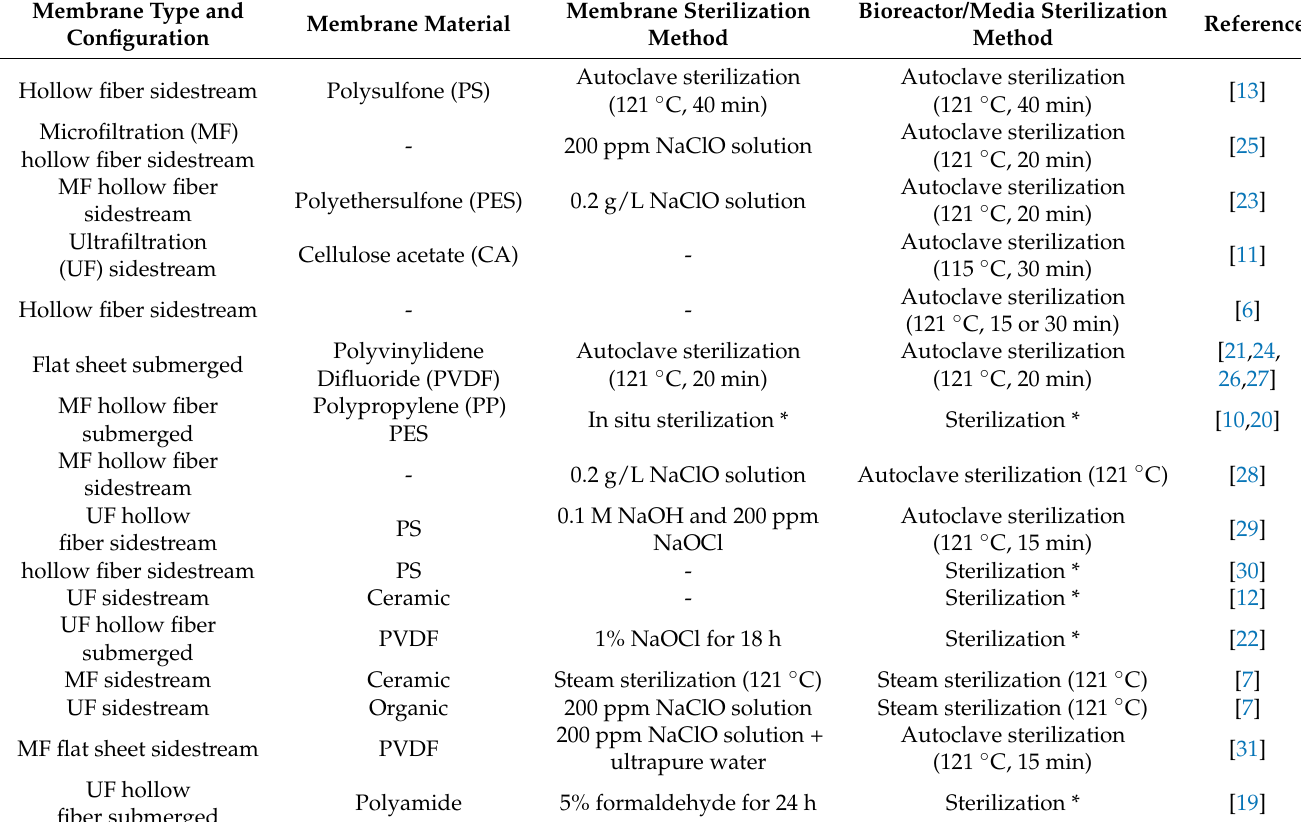
Table 1 summarizes the membrane type used and the sterilization methods applied in MBR systems; i.e., bioreactor fermentation coupled with membrane separation. In most cases, experiments took place in bench-scale fermenters of 1.5–5 L volume [6,13,21,23,24], while a few researchers focused on studying the fermentation process at higher volumes, with fermenters up to 15 L [11,20]. Membrane modules were re-used in the majority of the studies, although it is not clear how many times the membranes could be reused. In other cases (e.g., [22]), single-use membrane modules were employed in each experiment, which is apparently unsustainable from an economical point of view. Concerning the effect of the sterilization process on the membrane separation efficiency and the filtration performance (i.e., permeance, fouling rate, etc.), there are hardly any data on the aforementioned studies. Table 1. A summary of hybrid biotechnological/membrane separation processes and the applied sterilization method. The dashes denote absence of relevant